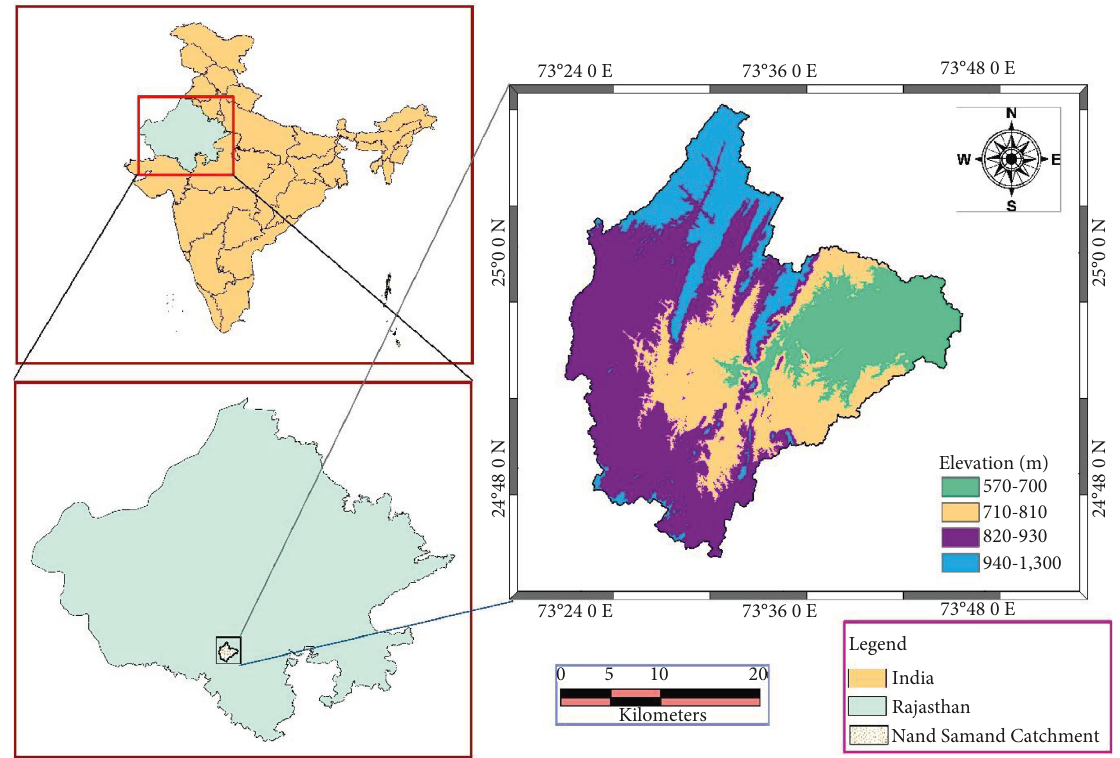
Figure 1: Study area